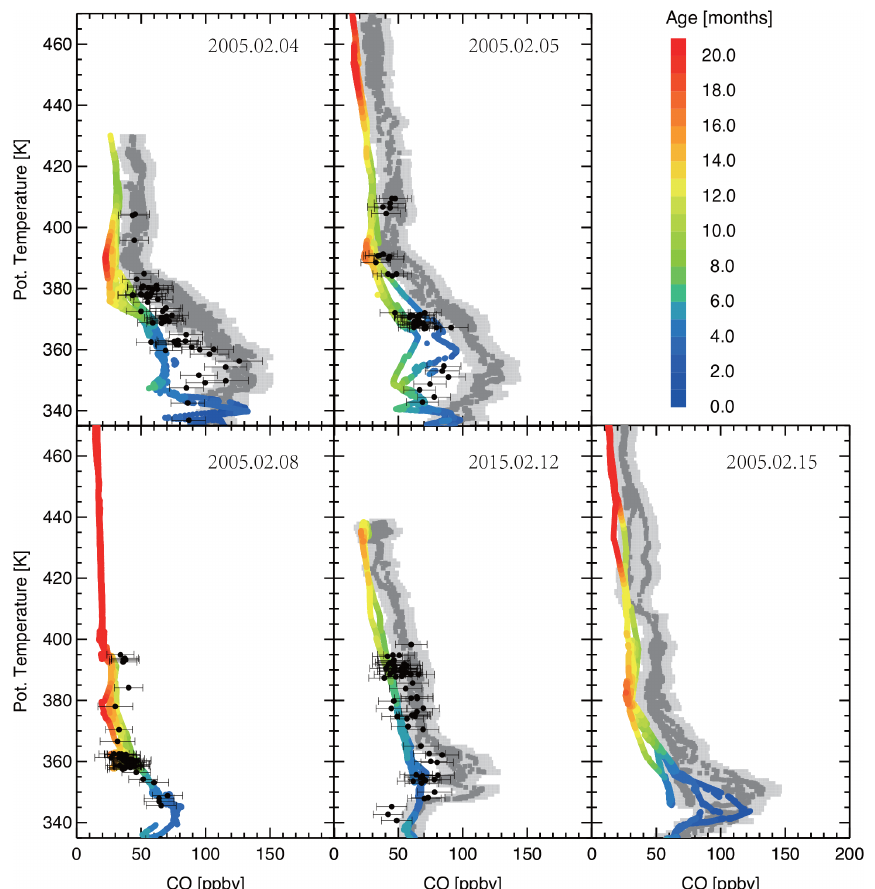
Figure 4. Comparison of the simulation of CO from CLaMS (coloured) with in situ measurements from the COLD instrument (dark grey) and the HAGAR instrument (black) on the Geophysica aircraft. The flights were conducted on 4 February 2005 (top left panel), 5 February 2005 (top right panel), 8 February 2005 (bottom left panel), 12 February 2005 (bottom middle panel), 15 February 2005 (bottom right panel). Note that HAGAR measurements are not available for 15 February 2005 and COLD measurements are not available for 8 February 2005. The mean age of air calculated by the model is colour-coded and given in months. The total measurement uncertainty is shown for both instruments (light grey shading for COLD and black error bars for HAGAR. (Total measurement uncertainty is determined as the square root of the sum of squares of the accuracy and precision of the